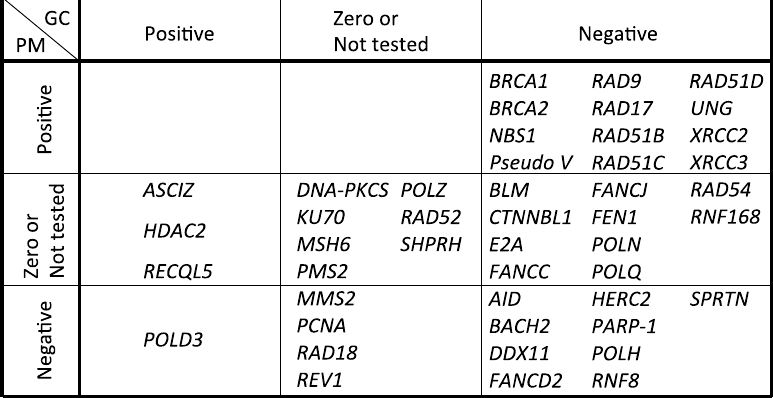
Figure 4. Genes involved in Ig gene conversion and hypermutation. GC and PM represent gene conversion and hypermutation, respectively. Positive, zero or negative effects by gene deletion or mutation on gene conversion and hypermutation were categorized.